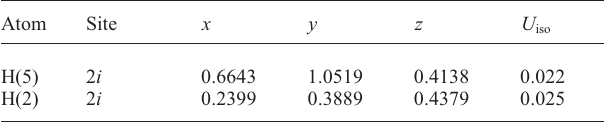
Table 2. Atomic coordinates and displacement parameters (in Å 2 )